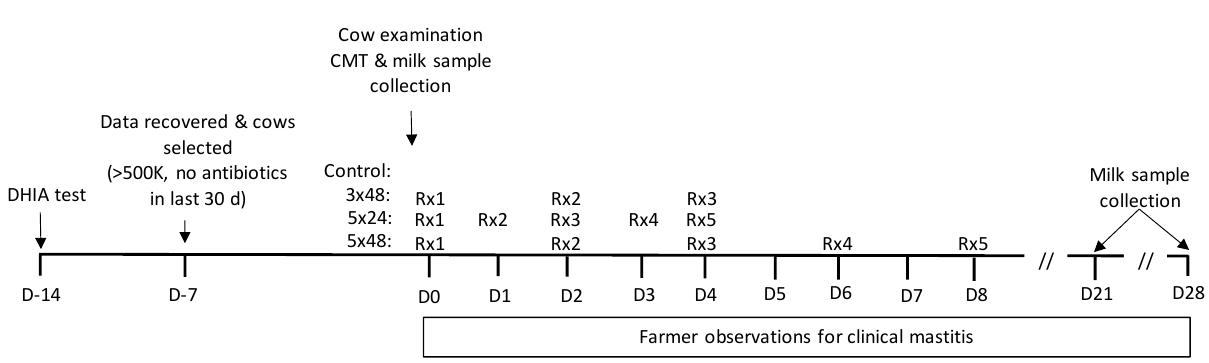
Figure 3. Diagram of cow procedures including data collation from dairy herd improvement testing (DHIA test), cow examination, California mastitis test (CMT) and treatment regime. Cows were allocated to no treatment (Control), 3 intramammary infusions of 200 mg cloxacillin at a 48 h interval (3 × 48), 5 treatments at 24 h interval (5 × 24), or 5 treatments at 48 hourly intervals (5 × 48). Rx indicates intramammary treatment.